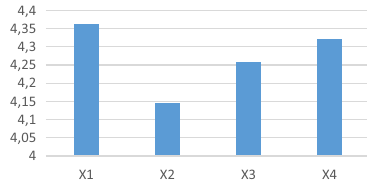
Figure 4. The average score of variable X1-X4 of PT Pelindo